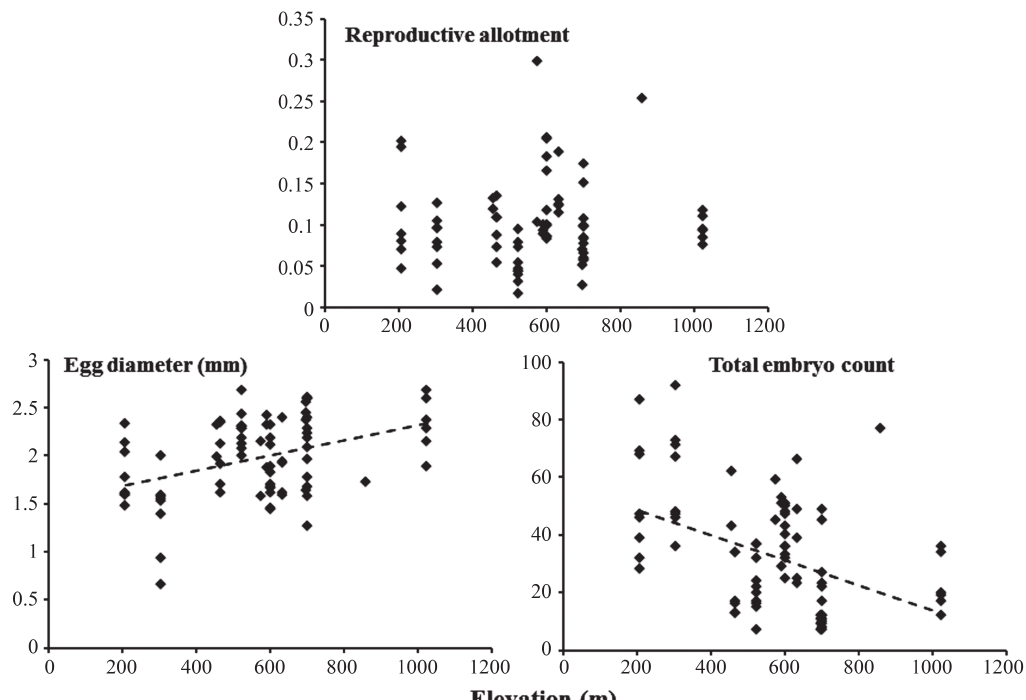
Fig. 4 . Changes in reproductive traits of female Heterandria bimaculata along an elevational gradient in Cusuco National Park, Honduras in summer 2013. Points represent actual values. Dashed lines represent fitted means from linear mixed models, accounting for nested effects of individual variability within sites, and total length of individuals. No fitted line is presented for reproductive allotment because this variable did not change significantly along the elevational